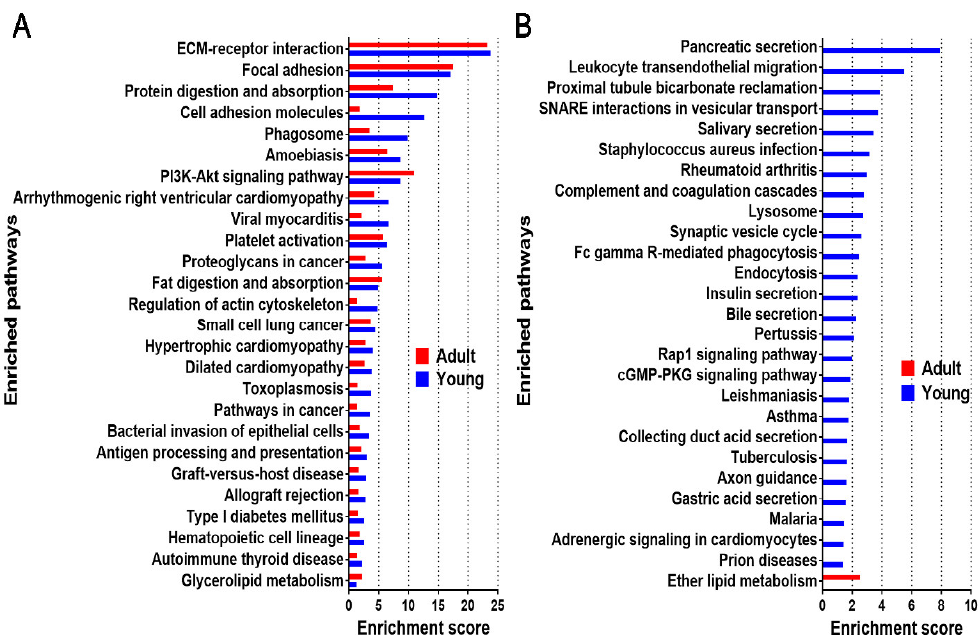
Figure 5. Enrichened pathway analysis in young ( n = 4) and adult ( n = 4) dpECM. ( A ) The enriched pathways identified in both young and adult dpECM. ( B ) The enriched pathways identified solely in young or adult dpECM. The bars show enrichment scores calculated by [−log10 ( p -value)] for individual pathways. These enriched KEGG pathways were confirmed using the Modified Fisher Exact test (EASE score p < 0.05).